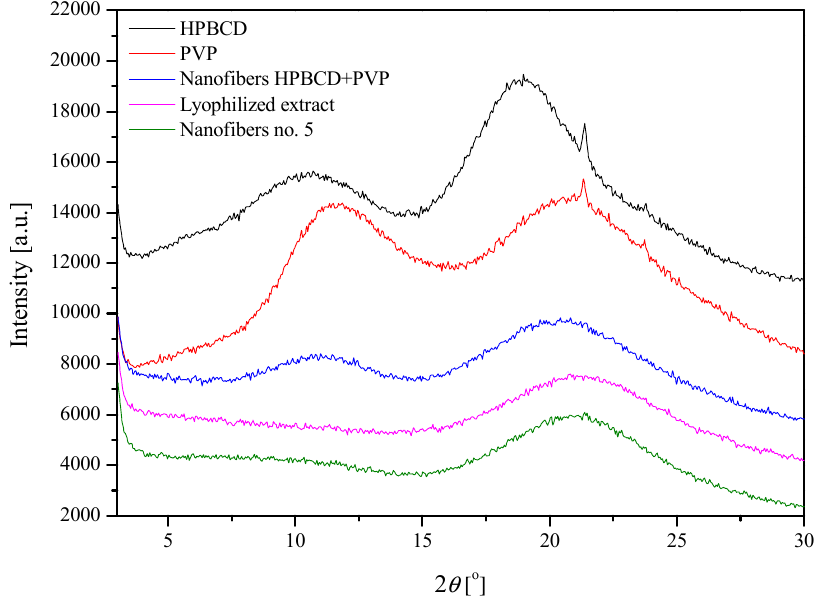
Figure 4. Diffractograms for powder systems and nanofibers no. 5.